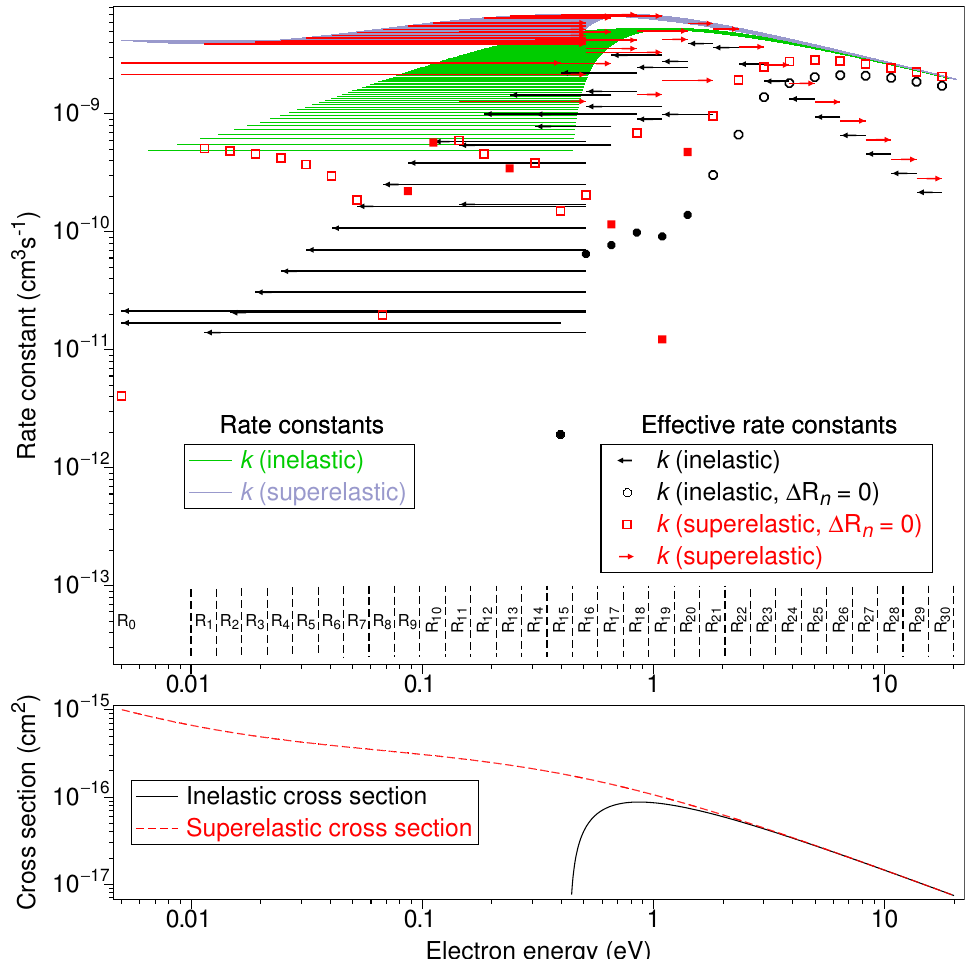
Figure 2. Rate constants (upper panel) and cross sections (lower panel) as a function of electron energy for electron–impact vibrational excitation (0 → 1) in OH. Rate constants for inelastic collisions are shown by green lines from the initial to the final electron energy. In the simulation (for transitions between pairs of the 31 energy subranges indicated by the vertical dashed lines), the effective rate constants are shown by arrows drawn from the midpoint of the initial subrange to the final, while symbols (circles for inelastic and squares for superelastic collisions) show the effective rate constants for the transitions where the initial and final electron energies are in the same subrange. Negative rate constants are indicated by solid circles for inelastic collisions and solid squares for superelastic